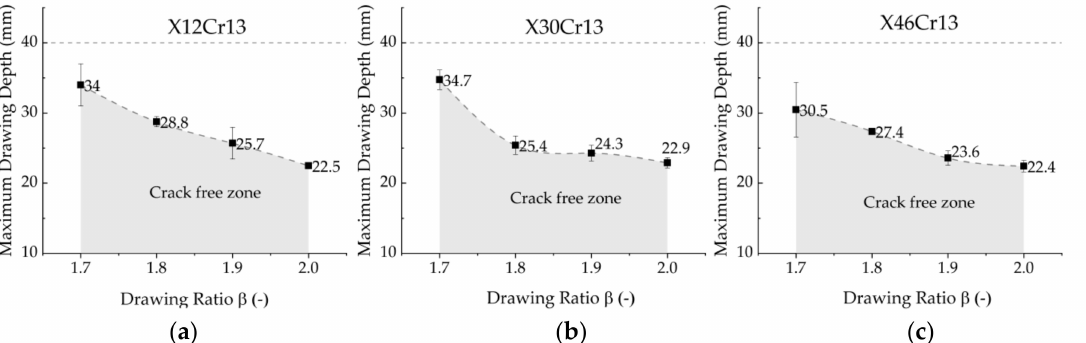
Figure 9. Maximum achievable drawing depth for di ff erent drawing ratios after austenitization at 1050 ◦ C for 300 and subsequent forming begin at 900 ◦ C with a constant flange gap of 2.5 mm for the X12Cr13 ( a ), X30Cr13 ( b ) and X46Cr13 ( c ) alloys. The maximum drawing depths of 34.0 mm and 34.7 mm are achieved for X12Cr13 and X30Cr13, respectively, at β = 1.7. X46Cr13, having the highest carbon content, which achieves a maximum drawing depth of 30.5 mm ( β = 1.7). At β = 2, the maximum drawing ratio for all three alloys has almost converged. Maximum drawing depths between 22.4 mm and 22.9 mm are achieved for blank diameters of 200 mm. The influence of the alloy composition on the achievable maximum drawing depth is therefore considered as not significant. The achievable drawing depth is rather influenced by the initial diameter of the sheet